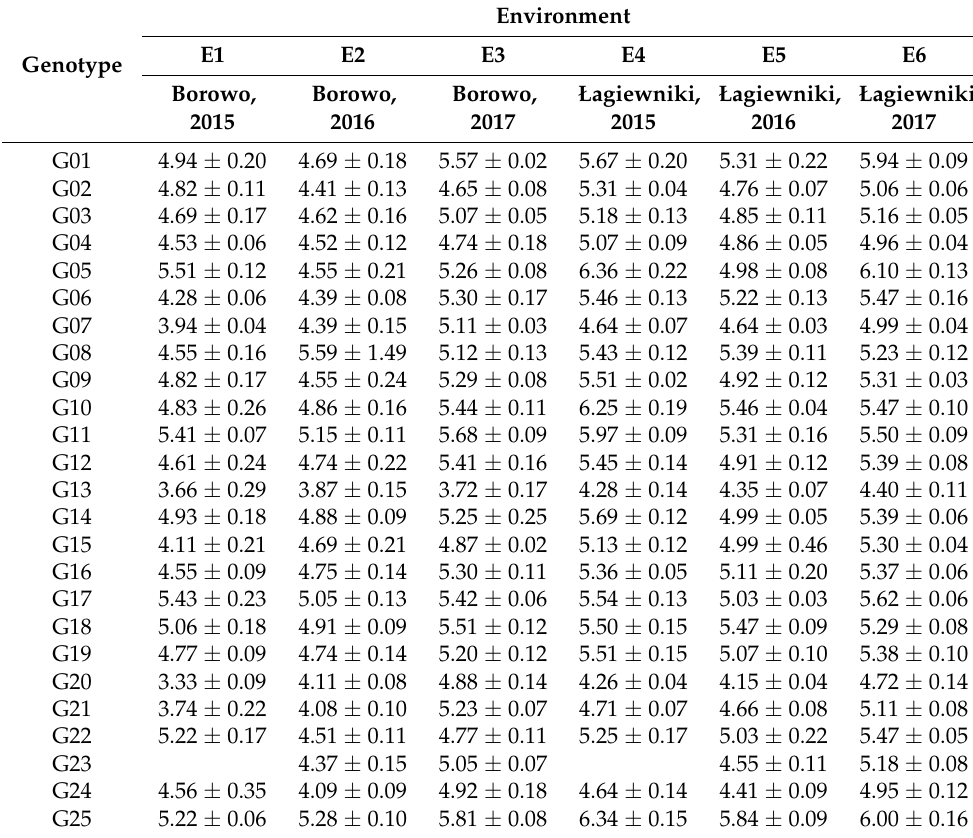
Table 12. Mean values ± standard deviations (s.d.) for the weight of 1000 seeds of winter oilseed rape genotypes in particular environments.